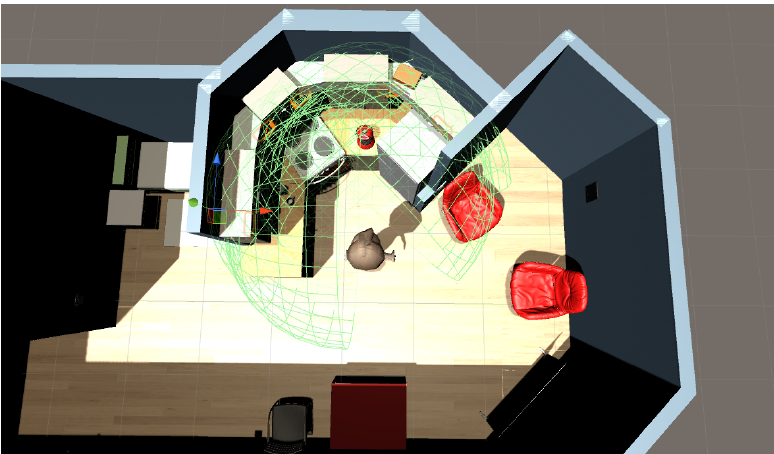
Figure 15. Screenshot of RFID antenna range.